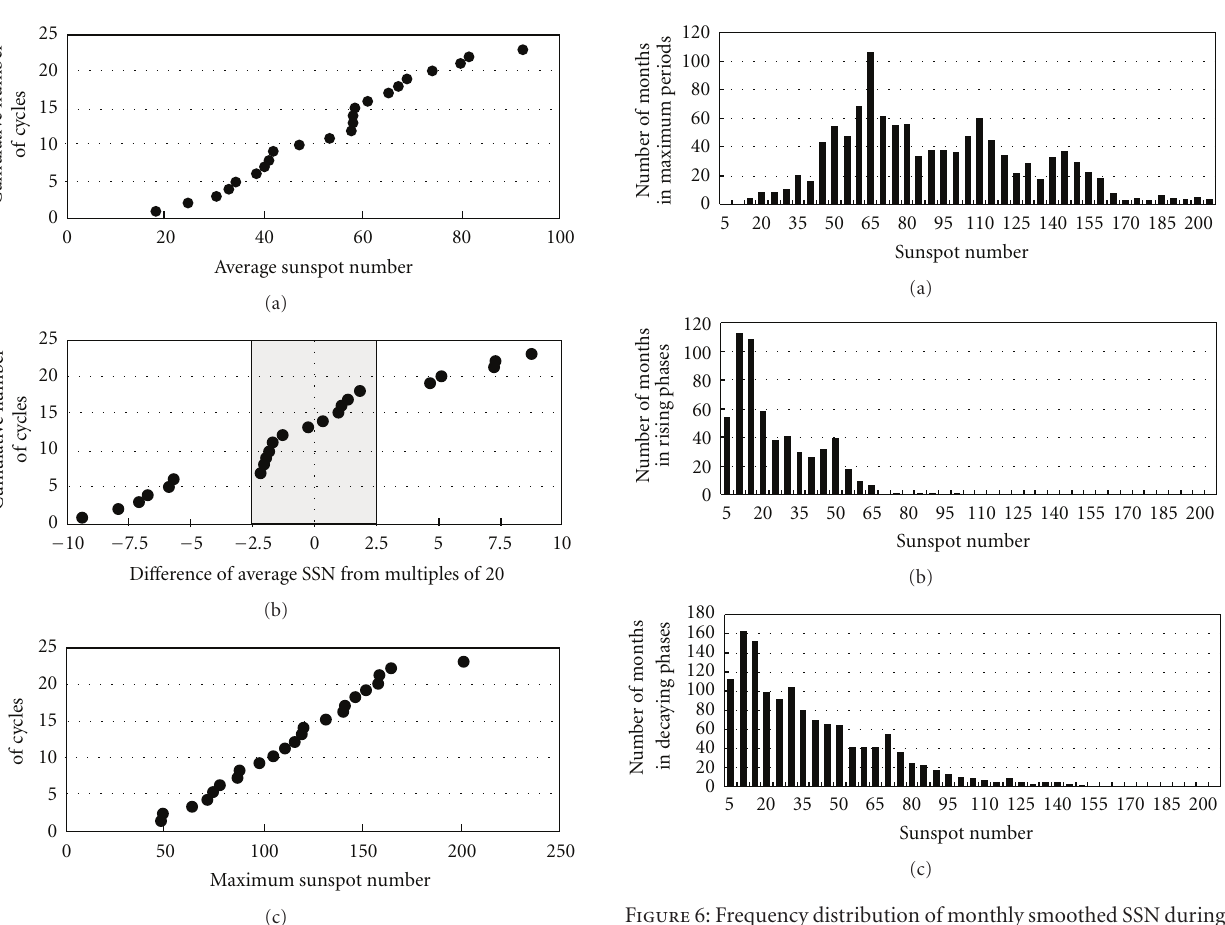
Figure 6: Frequency distribution of monthly smoothed SSN during (a) periods at solar maximum (the period from two years before each of the maximums of the SSN to two years after the maximum), (b) periods of rising phase (the period from the minimum SSN to two years before the beginning of the solar maximum period), and (c) periods of decaying phase (the period from the end of each of the solar maximum periods to the minimum SSN), respectively. The abscissa and the ordinate represent the monthly SSN and number of months,